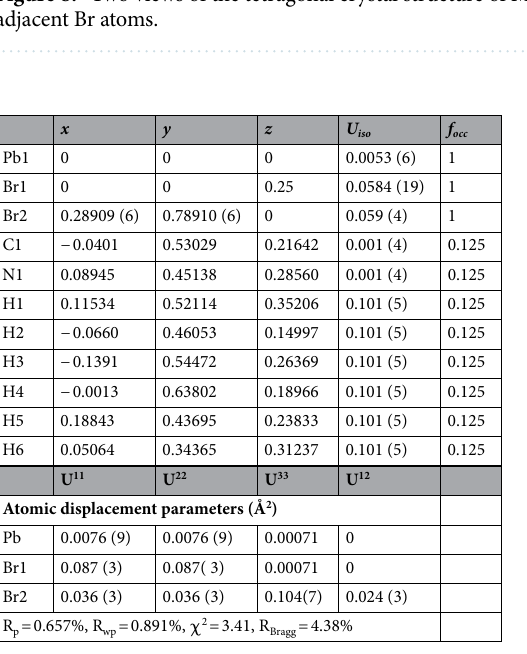
Table 5. Crystallographic data for MAPbBr 3 phase in the tetragonal system ( I 4 /mcm) from NPD at 155.6 K. a = 8.2815(5) Å, c = 11.8508(8) Å and V = 812.77(8) Å 3